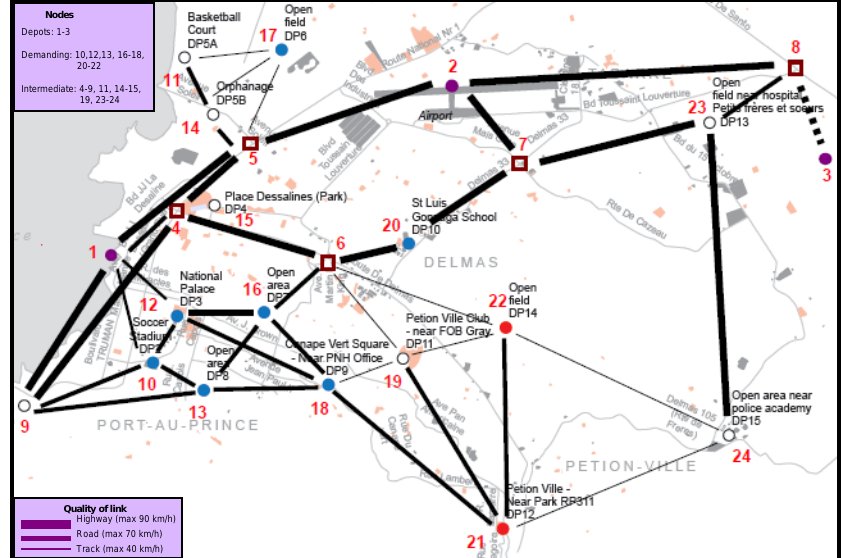
Fig. 1. Transport network at Port-au-Prince (OCHA, 31 January